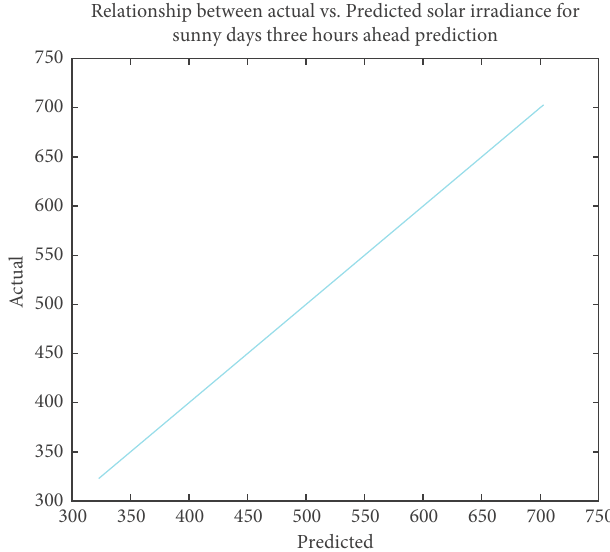
Figure 12: Relationship between actual vs. predicted solar irradiance for sunny day three-hour-ahead prediction.